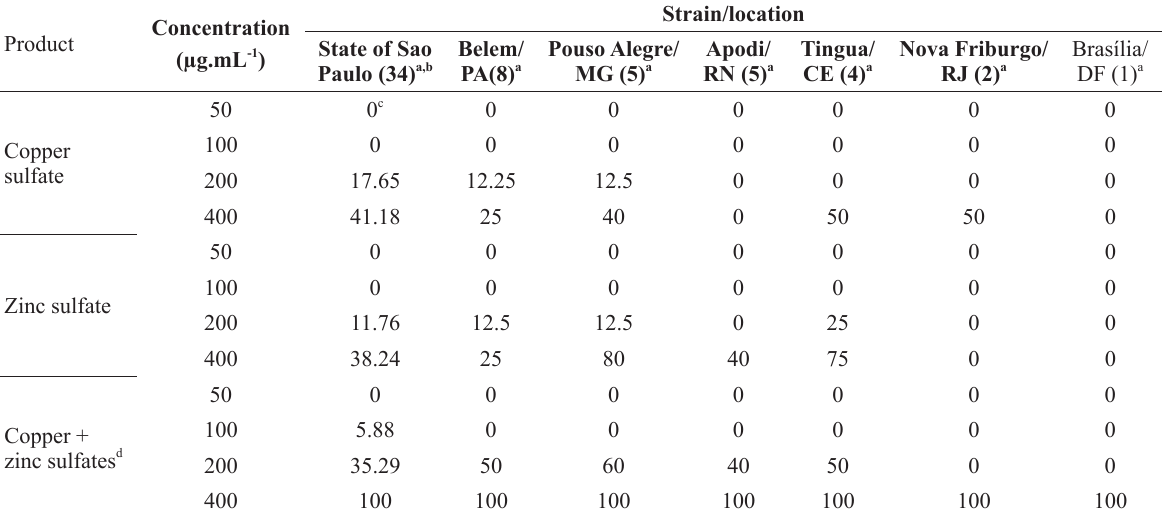
a Number of strains analyzed; b Several localities; c Percentage inhibition; d Mixture containing 50% of copper and 50% of zinc